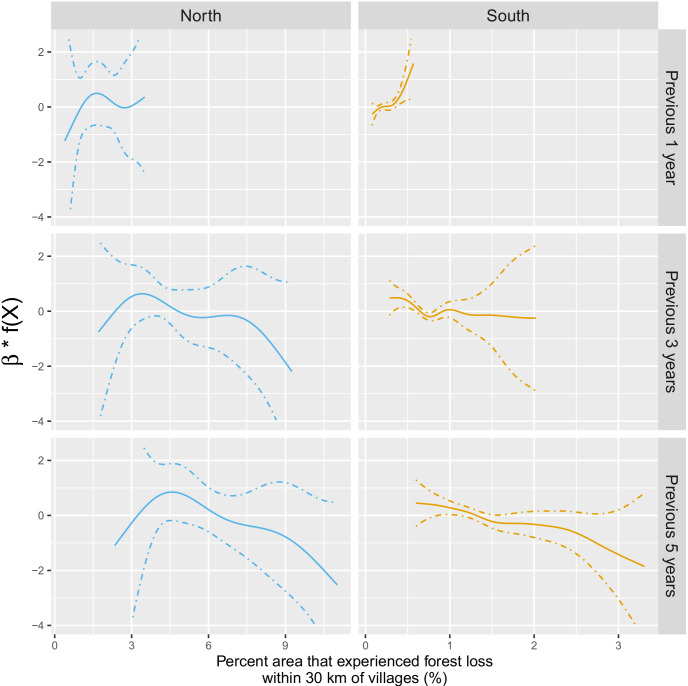
Adjusted relationship between deforestation and malaria incidence.All models were adjusted for environmental covariates and forest cover on top of the probability of seeking treatment, the spatio-temporal structure of the data (f⁢(t), f⁢(L⁢a⁢t,L⁢o⁢n⁢g) and village random intercepts) and malaria incidence in the previous 1 and 2 months. See Materials and methods for details. Note that scales are different between buffer radius for better visualization. Appendix 1—figure 14 shows the raw scatterplot between monthly village malaria incidence rate and deforestation. Appendix 1—figure 15 and Appendix 1—figure 16 show the raw time series of malaria incidence, forest cover and percent area that experienced forest loss.